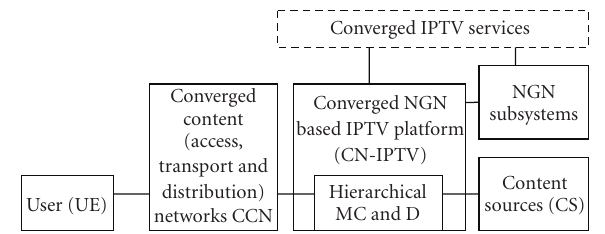
Figure 2: High-level view to IPTV